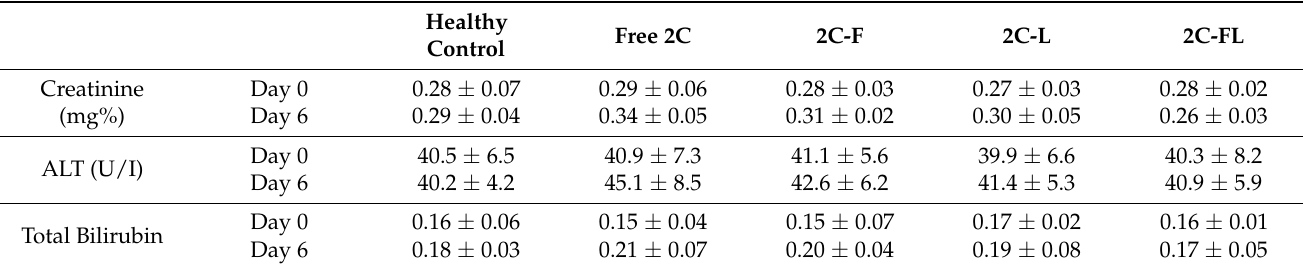
Figure 4. Percent hemolysis of erythrocytes caused by 2C-F, 2C-L, and 2C-FL formulations. Erythro- cytes from the healthy rabbit were incubated with different concentrations of free 2C, 2C-F, 2C-L, and 2C-FL for 1 h at 37 ◦ C. Data are presented as the mean ± SD of three independent experiments. In vivo toxicity parameters showed that there were no alterations in the hematological profile or the weight of the organs after six days. The changes in the biochemical parameters caused before day one and on the sixth day after the last dose administration are given in Table 3. The 2C-FL group showed no statistical differences in the creatinine levels compared to the healthy control values ( p < 0.05). Both the ALT and bilirubin levels also did not present a statistical difference in the 2C-FL-treated group. Similarly, there was no obvious change in the levels of serum creatinine, ALT, and bilirubin values in the 2C-F and 2C-L groups. Regarding the hematological values of the free 2C group mice, although the levels of serum creatinine, ALT, and bilirubin showed an increase in comparison to the control group, the values were within the expected values of healthy mice. Table 3. Serum levels of creatinine, aminotransferase alanine (ALT), and bilirubin were evaluated in healthy mice after the administration of a single dose of 2C-F, 2C-L, and 2C-FL nanoparticles. Data are presented as the mean ± SD of three independent